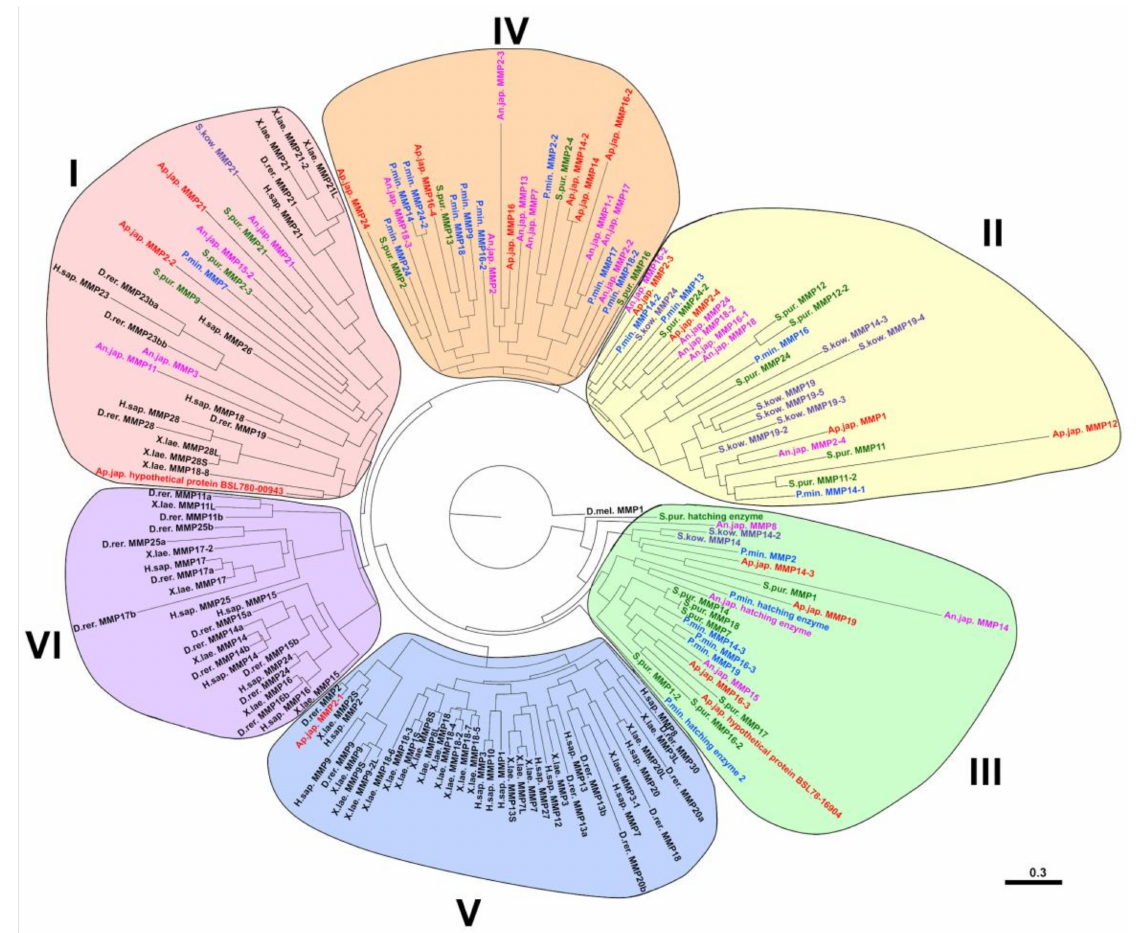
Figure 5. Phylogenetic tree showing the relationships of MMPs of vertebrates, hemichordates, and echinoderms. Crinoids ( Anneissia japonica )—pink color, asteroids ( Patiria miniata )—blue color, echinoids ( Strongylocentrotus purpuratus )—green color, holothurians ( Apostichopus japonicus )—red color, hemichordates ( Saccoglossus kowalevskii )—deep-blue color, vertebrates— black color. Determination of conserved regions of the putative amino acid sequences was carried out using the Gblock program. Construction of the phylogenetic tree was done using the MrBayes/Maximum Likelihood algorithm and the online service CIPRES (http://www.phylo.org, accessed on 15 March 2021). The nucleotide and amino acid sequences were analyzed using the Partitionfinder 2.1.1 [101,102]. The trees were visualized in the FigTree